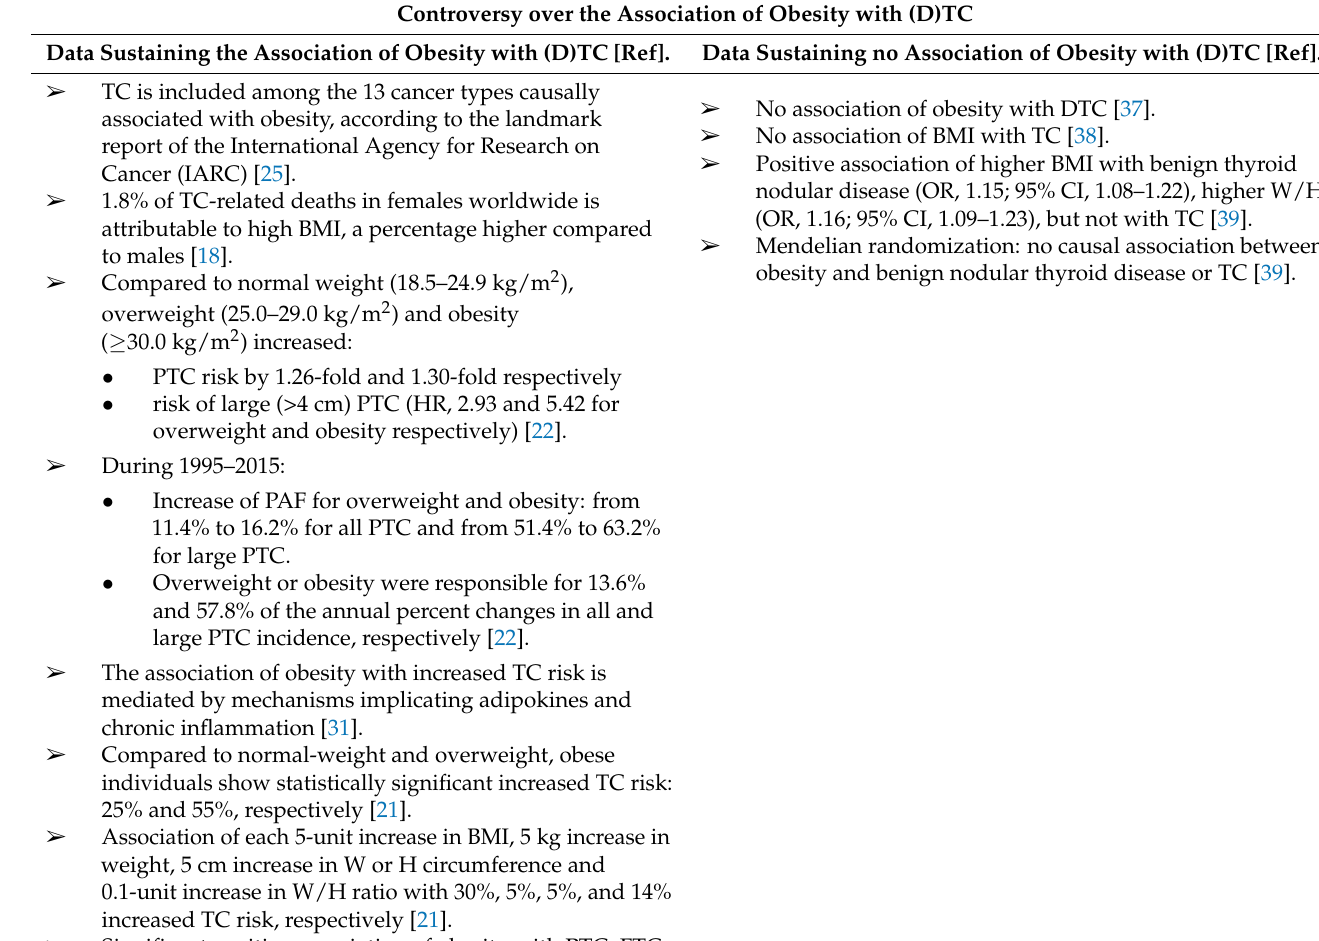
Table 1. Controversial data on the association between obesity and (D)TC. Controversy over the Association of Obesity with (D)TC Data Sustaining the Association of Obesity with (D)TC [Ref]. Data Sustaining no Association of Obesity with (D)TC